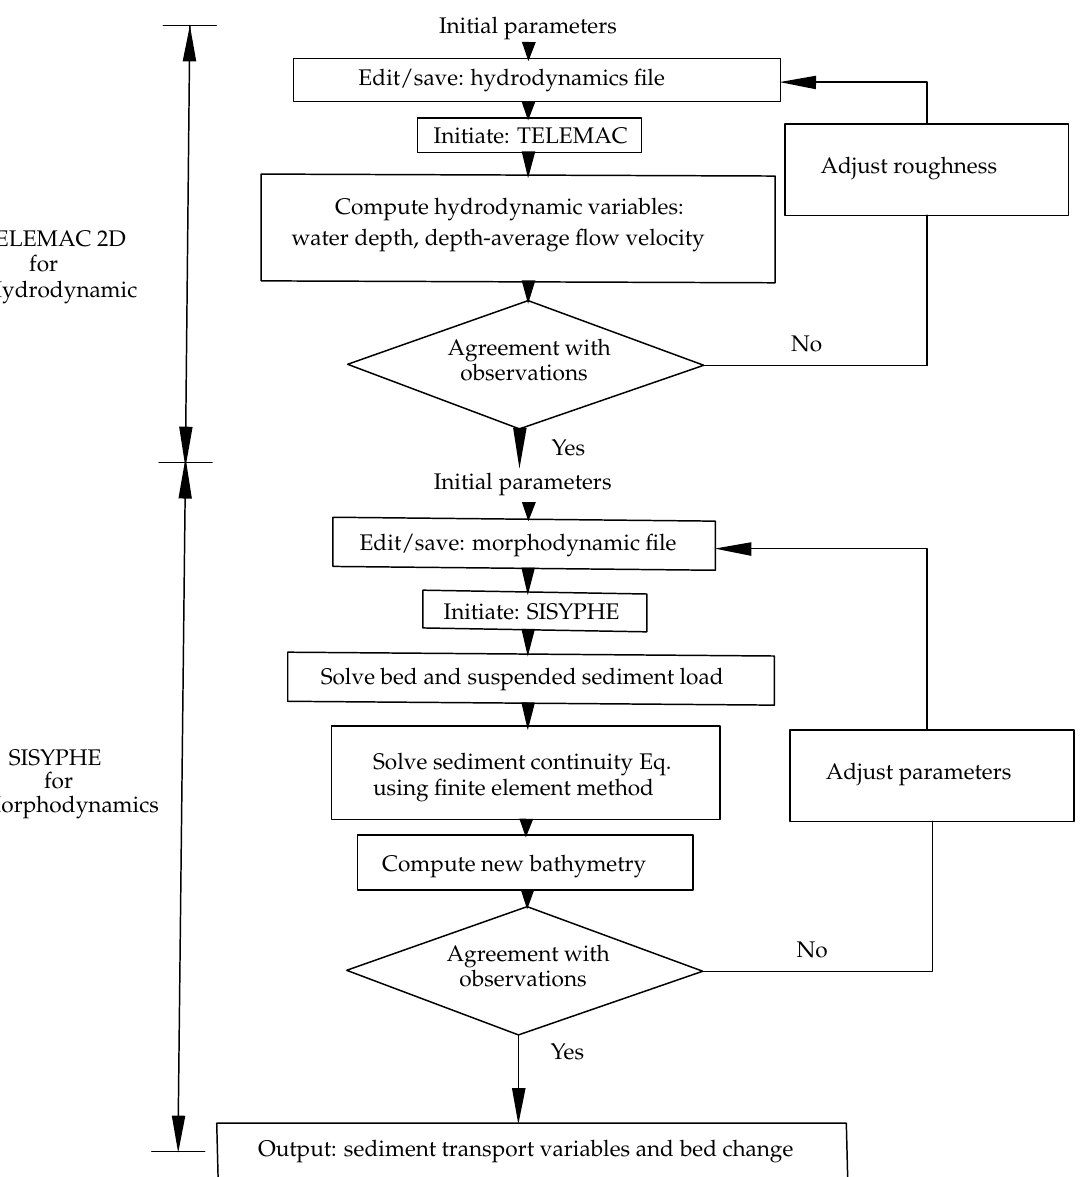
Figure 7. Algorithm for model calibration. The algorithm for TELEMAC and SISYPHE works in an uncoupled way where morphodynamic calibration only start after hydrodynamic calibration finished.